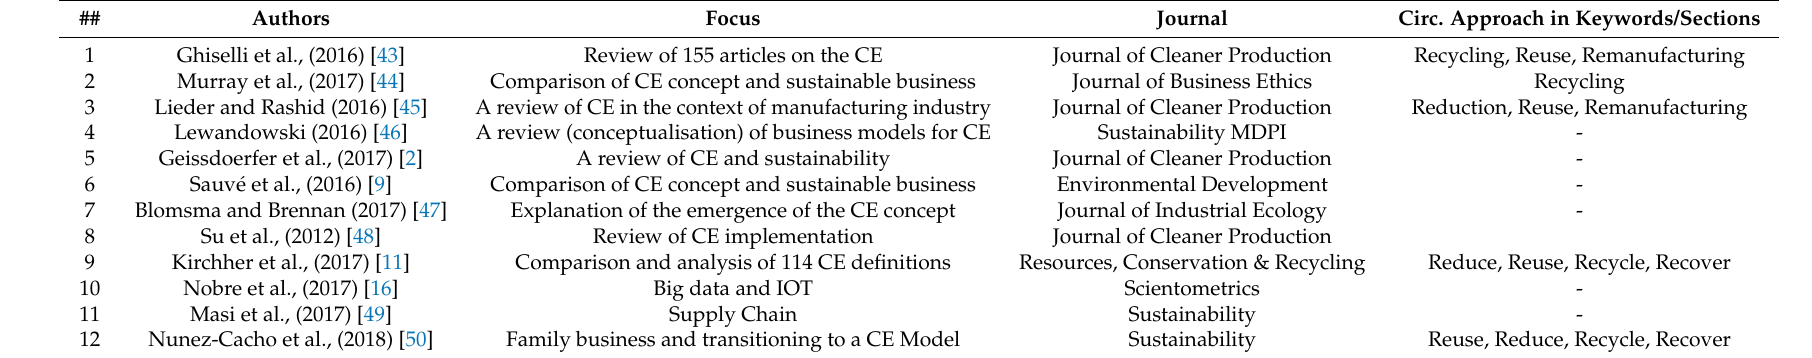
Table 1. Most recent reviews of the circular economy (CE)